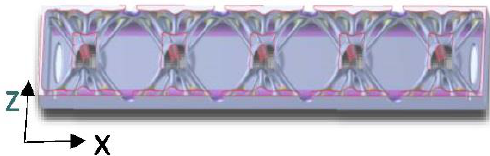
Figure 13. Schematic the edge insert cross section illustrating the macro-lattice supporting the top horizontal surface.